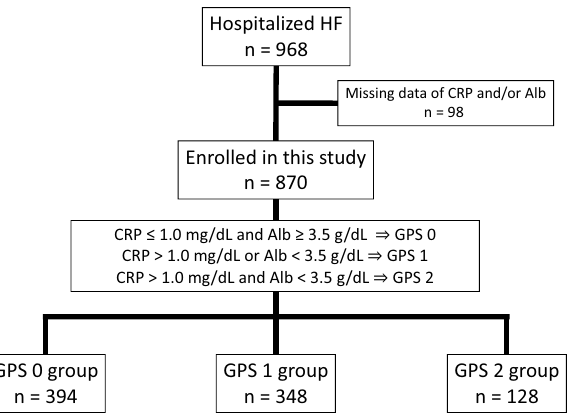
Figure 1. Flow diagram of study recruitment. Alb albumin, CRP C-reactive protein, GPS Glasgow Prognostic Score, HF heart